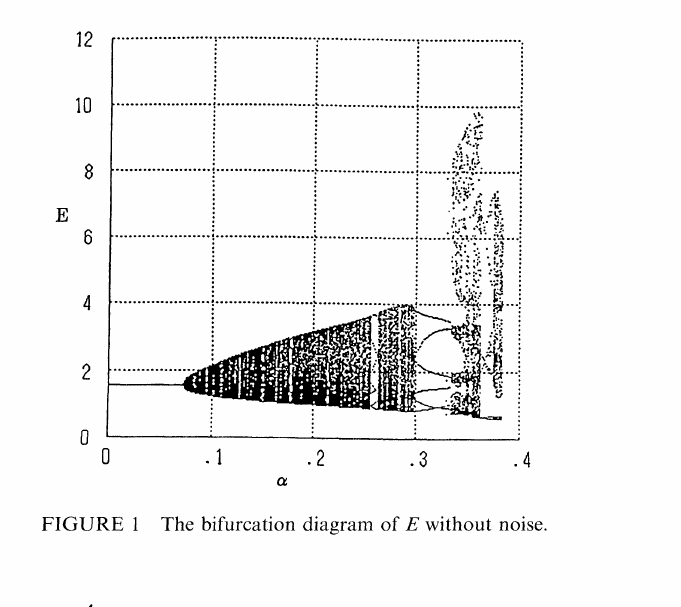
The bifurcation diagram of E without noise.